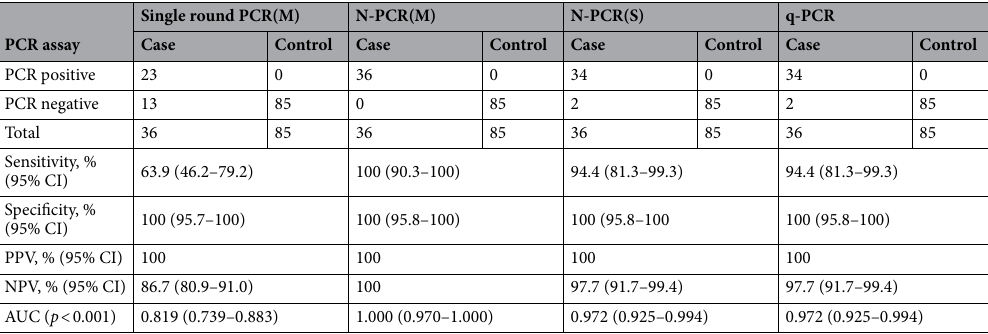
Table 1. Sensitivity and specificity of reverse transcription (RT) polymerase chain reactions (PCR) targeting the M segment of the SFTS virus (single-round PCR-M), RT nested PCR targeting the M-segment of the SFTS virus (NPCR-M), RT-nested PCR targeting the S-segment of the SFTS virus (NPCR-S), and real-time RT PCR targeting the S-segment of the SFTS virus (QPCR-S) conducted in this study for their clinical evaluation of 36 samples from severe fever with thrombocytopenia (SFTS) patient and 85 samples from non-SFTS infectious disease cases. CI confidence interval, PPV positive predictive value, NPV negative predictive value, AUC area under curve.